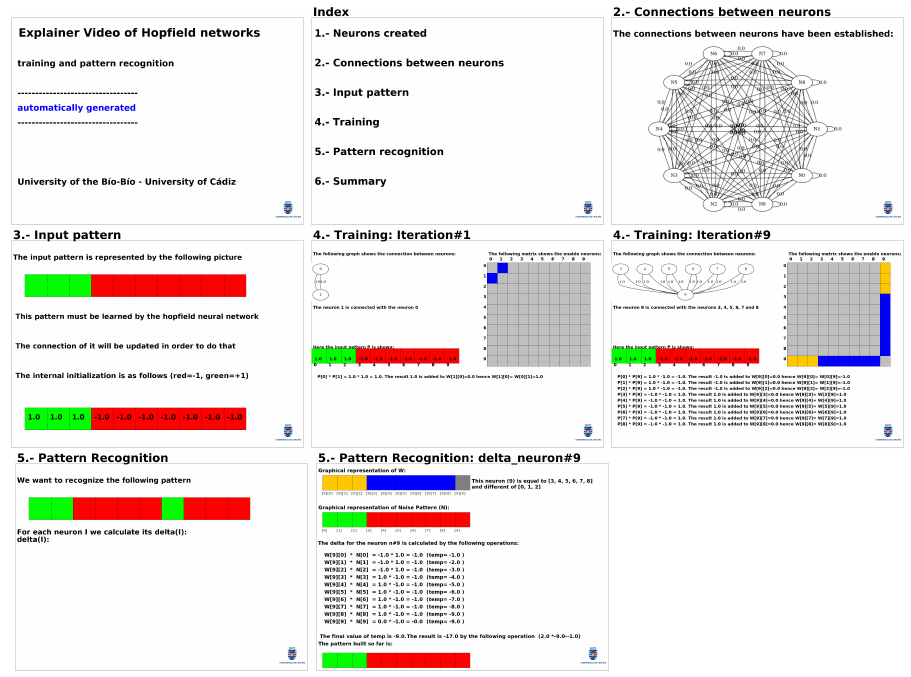
Figure A1. A subset of frames automaically